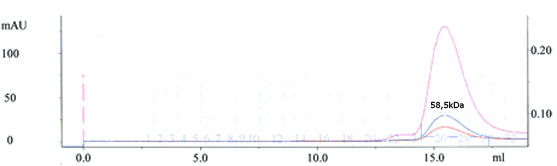
Gel-filtration profile of the purified YfhQ protein. Magenta line: UV 232 nm, red: UV 260 nm, blue: UV 280 nm. The peak at 16 ml corresponds to a dimeric form of YfhQ.